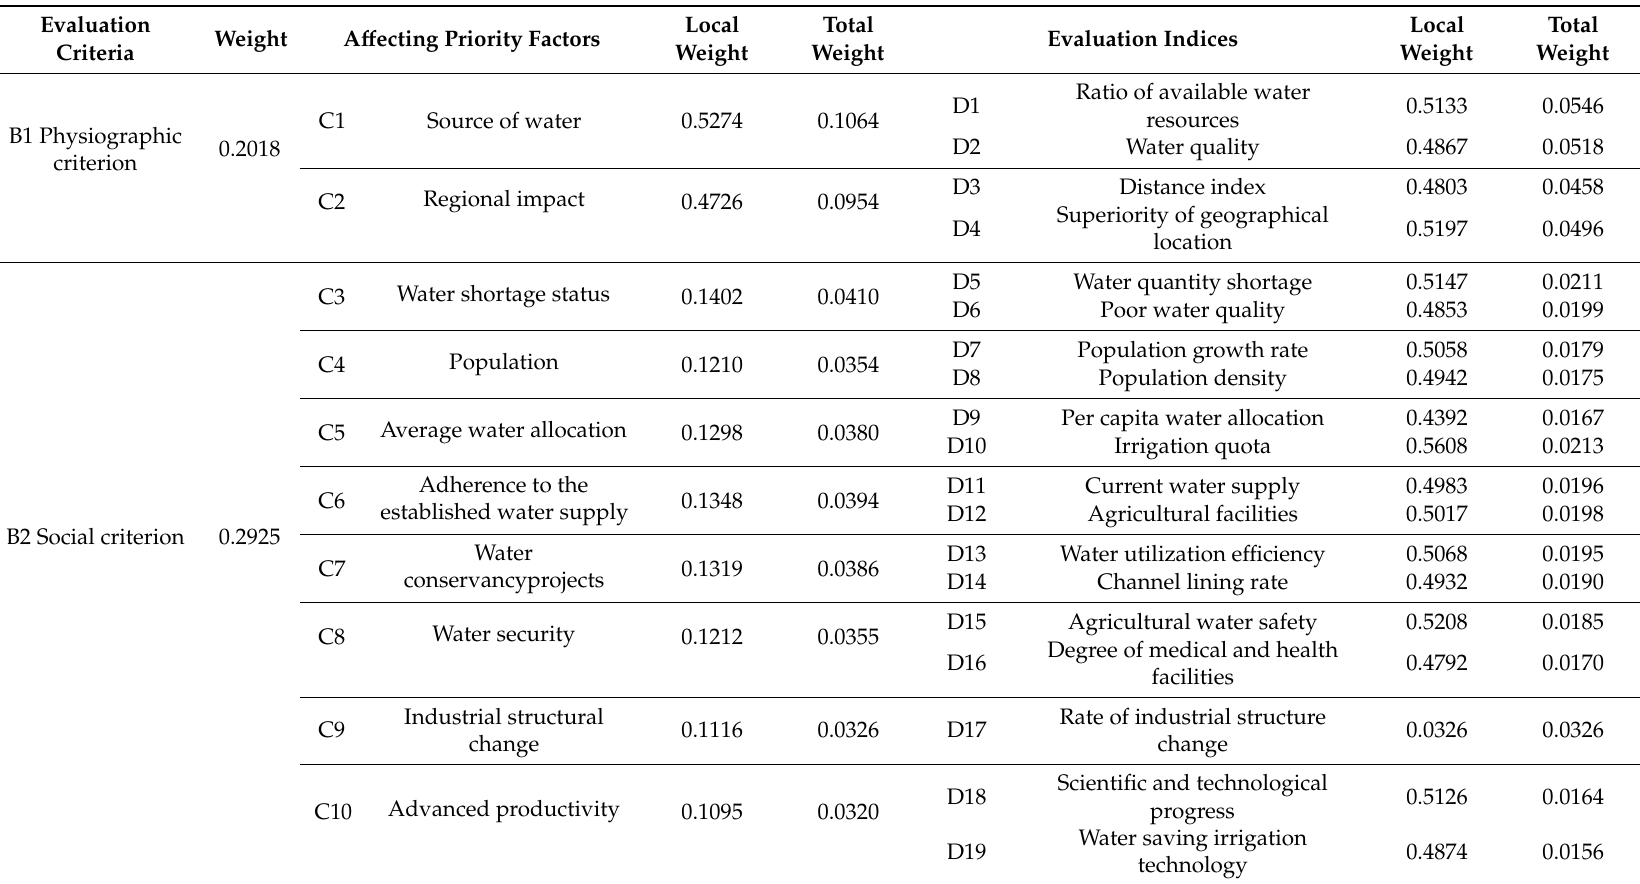
Table A5. The total weight of evaluation